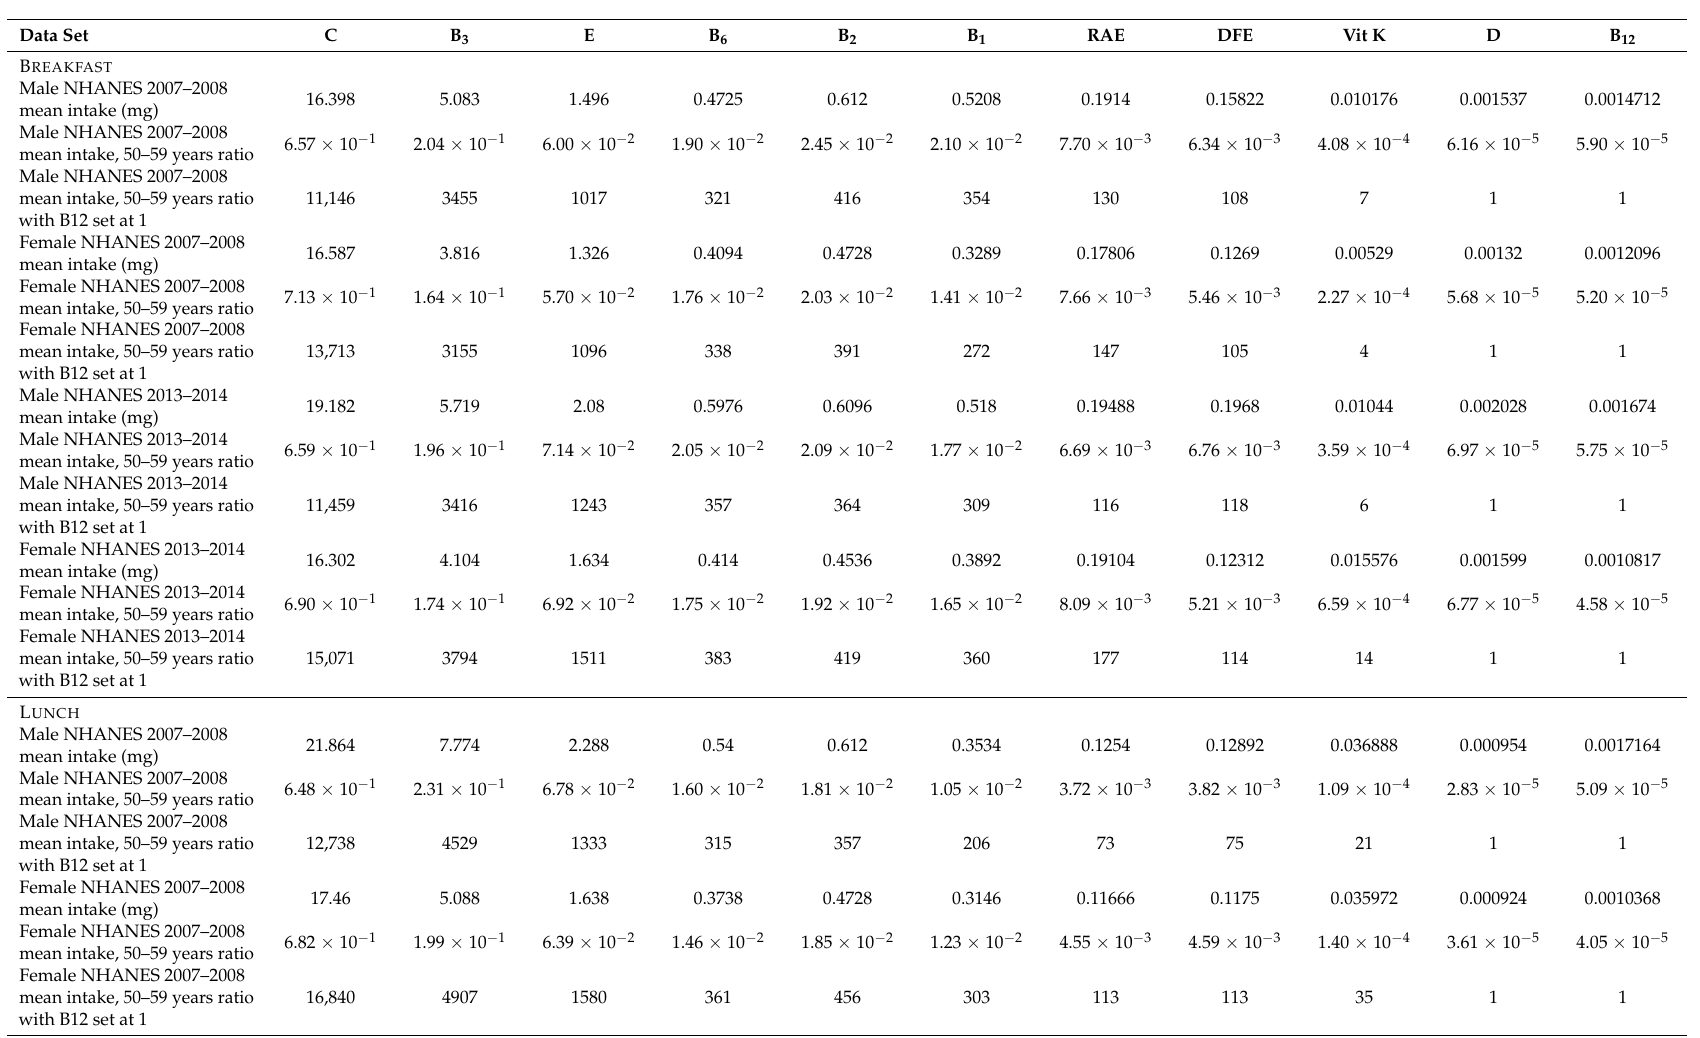
Table 4. The vitamin intakes from food (National Health and Nutrition Examination (NHANES) 2007–2008 and 2013–2014 data), their ratios and their ratios relative to B 12 at meal occasions, for males and females 51–59